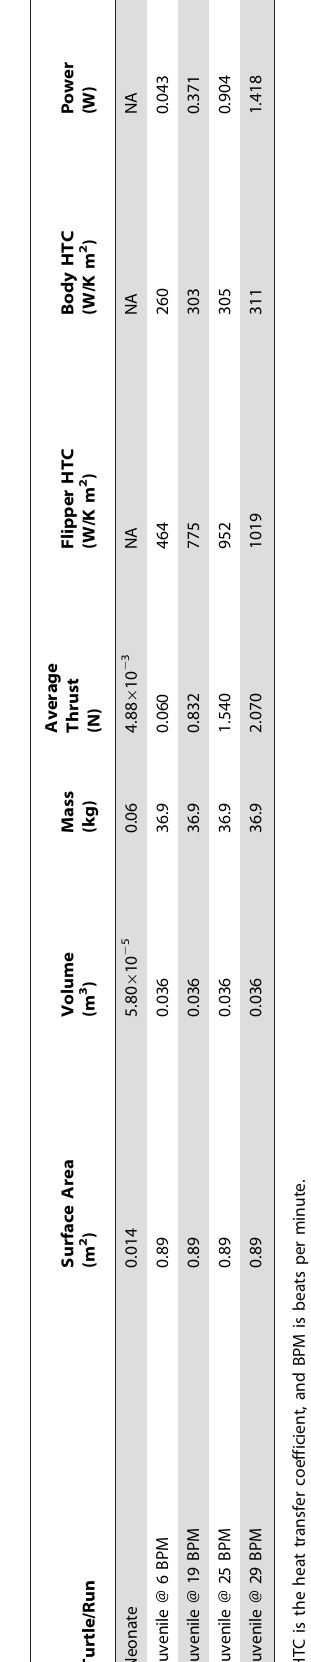
and divided into four zones. The 14% of the flipper closest to the